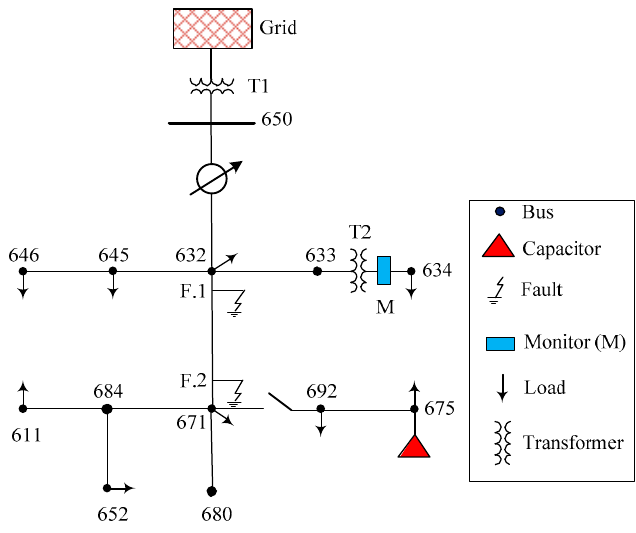
Figure 12. The tested IEEE 13-bus system [41].